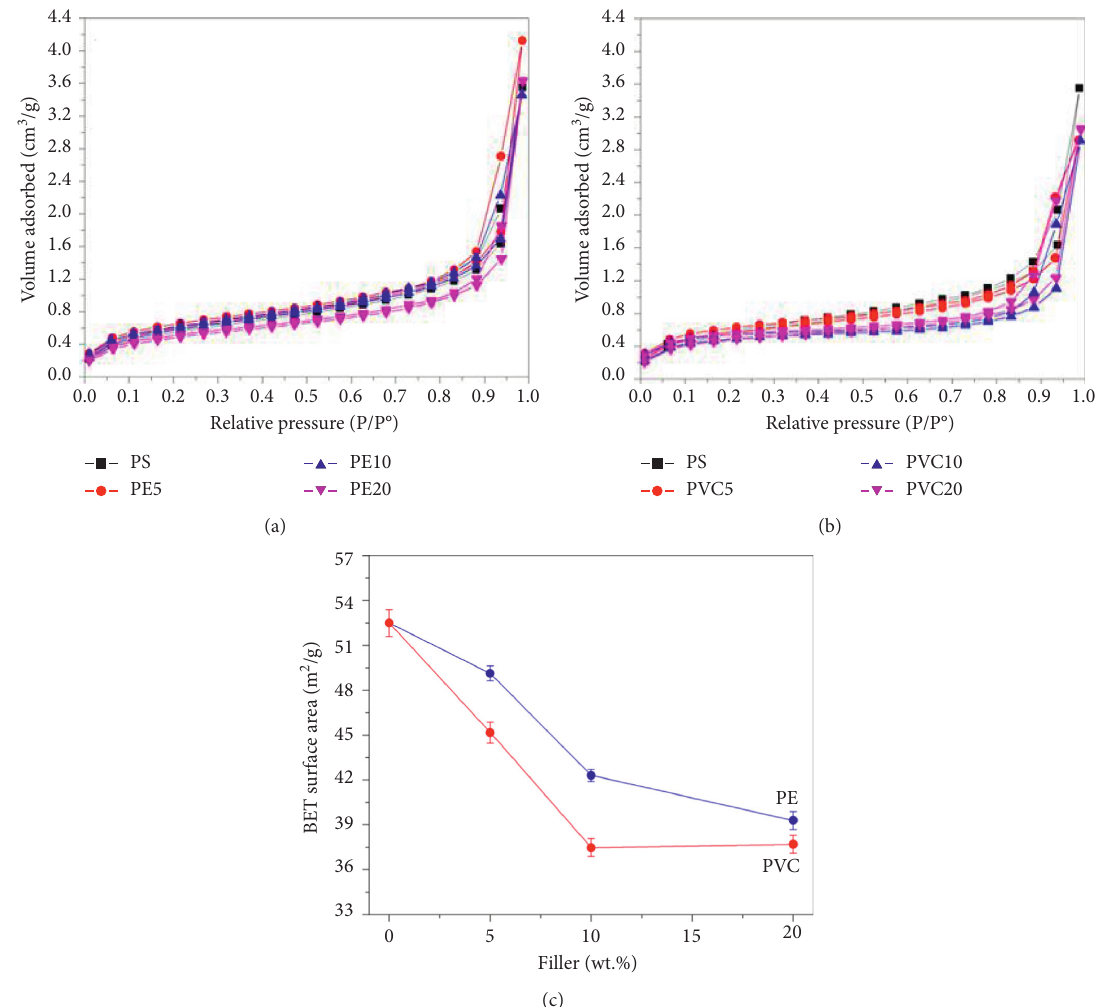
Figure 3: N 2 -adsorption isotherms of (a) PS-PE, (b) PS-PVC fibrous sorbents, and (c) their BET surface